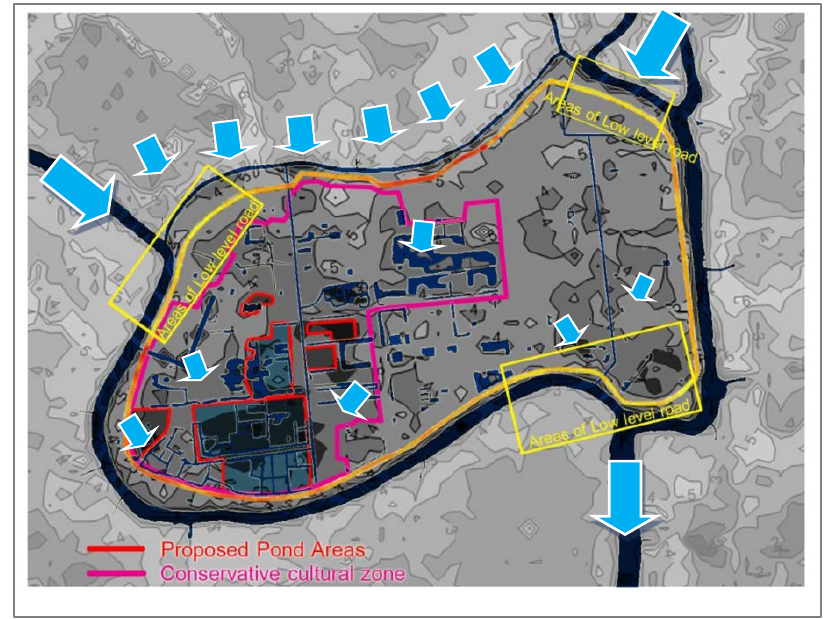
Figure 12. Analysis of locations for potential flood mitigation measures. Arrows indicate the flood propagation towards the southwest region.